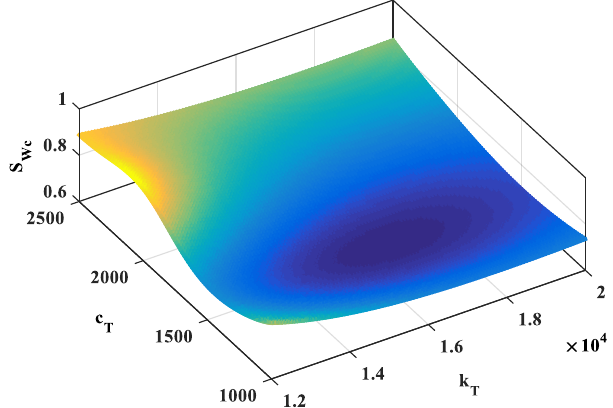
Figure 9. The variation of S Wc as a function of c T and k T .